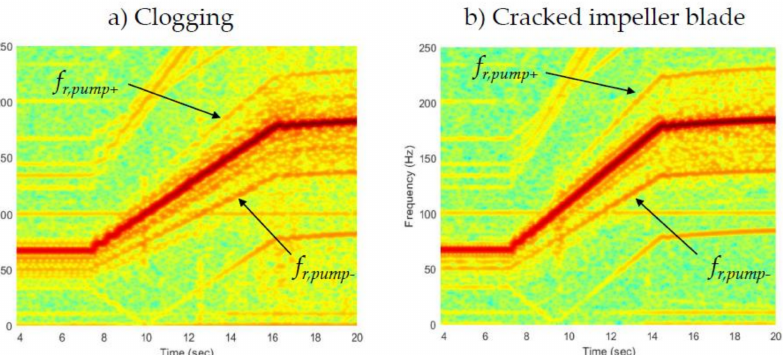
Figure 13. Time-frequency analysis of the stator current with ( a ) one clogged impeller channel and ( b ) a cracked impeller